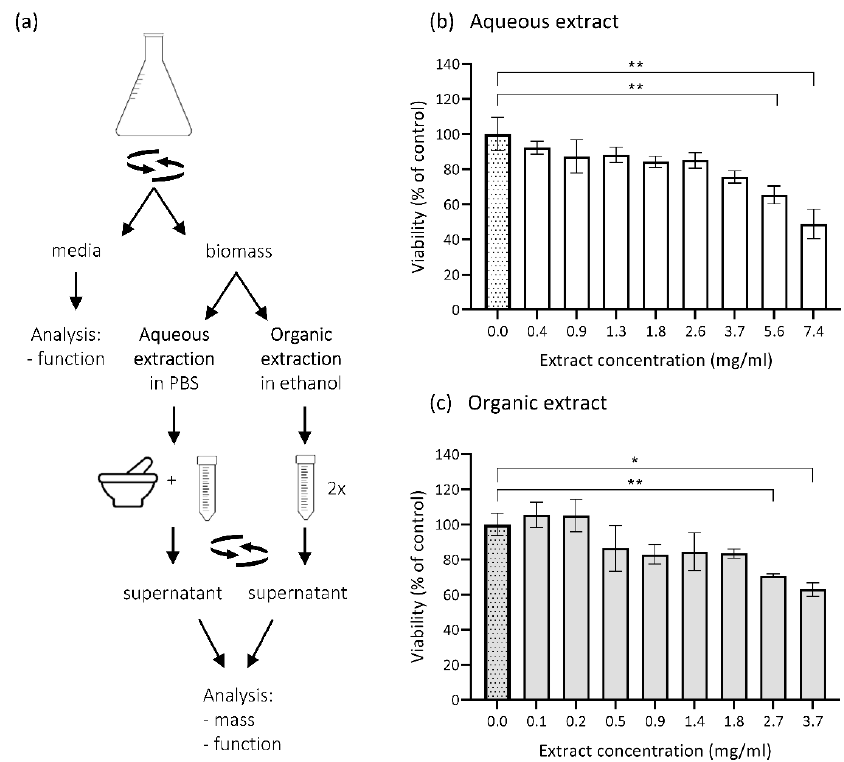
Figure 3. Cytotoxic effect of E. dermatitidis extracts on neuroblastoma cells SH-SY5Y. ( a ) Biomass extraction of four-day-old E. dermatitidis culture was performed according to the scheme. Cytotoxic effects of E. dermatitidis extracts were analysed on SH-SY5Y cells. Cells were cultured to 60%–70% confluence and treated with various concentrations of ( b ) aqueous or ( c ) DMSO-diluted ethanolic extracts. After 48 h, the neutral red uptake assay was performed and the cell viability was assayed as described in Section 2.10. Each bar represents mean ± SD of three biological repetitions. The first dotted bar represents the viability of the control cells (100%) in culture medium supplemented with ( b ) phosphate buffered saline (PBS) or ( c ) DMSO (* p < 0.05; ** p < 0.01; Kruskal–Wallis statistics). Exposure of the neuroblastoma cells SH-SY5Y to potential volatile organic compounds (VOC) from 1-, 2-, or 8-day-old EXF-10123 culture, or to the fresh fungal medium, did not significantly influence viability as compared with untreated control as tested with trypan blue staining after 48 h. 3.4. Isolation and Characterisation of E. dermatitidis EVs and Their Cytotoxic Effect on SH-SY5Y Cells